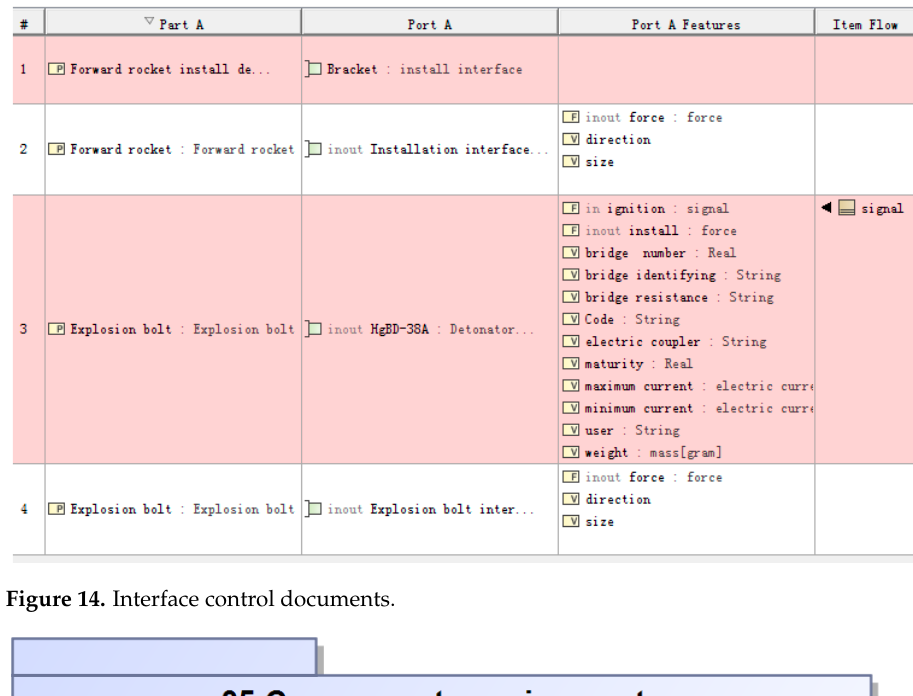
Figure 13. The change in key parameters.